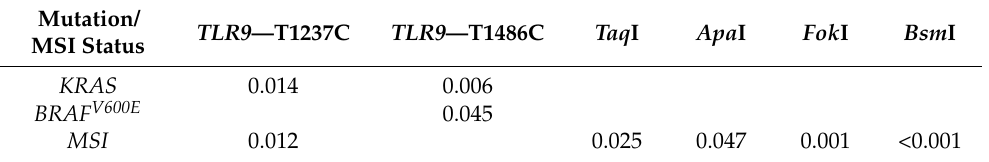
Table 5. Correlation of tumor mutational ( KRAS / NRAS / BRAF V600E ) and microsatellite instability (MSI) status with microbial DNA fragments, TLR, and VDR gene mutant alleles (values against each category represents p